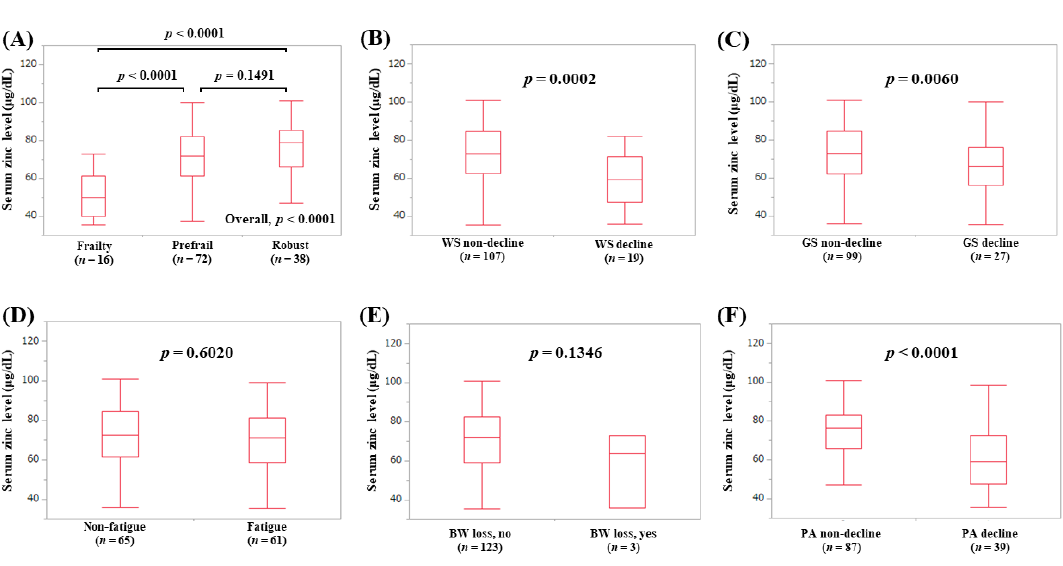
Figure 8. Serum Zn level according to the frailty status ( A ) and serum Zn level according to each frailty phenotype in male patients: ( B ) walking speed, ( C ) grip strength, ( D ) fatigue, ( E ) body weight loss, ( F ) physical